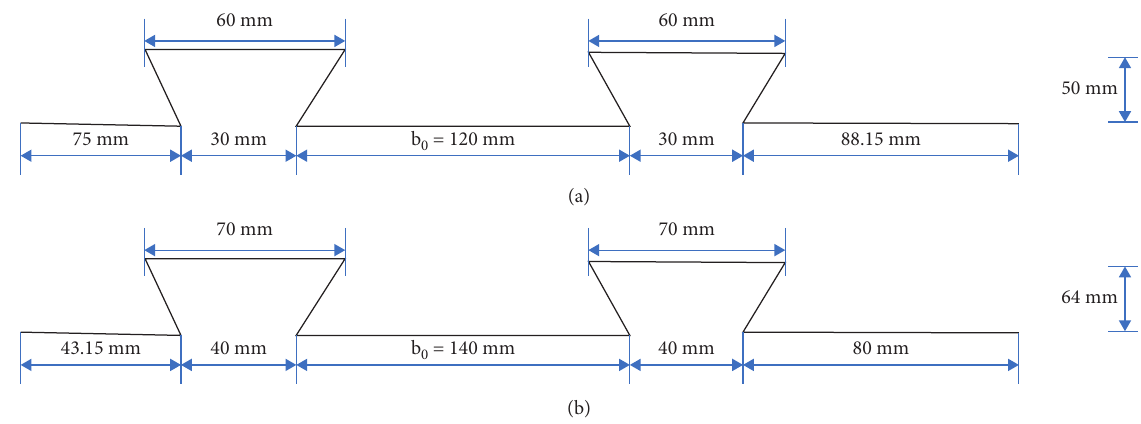
Figure 2: Definition of symbols for reentrant profiled steel sheeting including dimensions. Table 1: Geometric dimensions and concrete strength as parametric